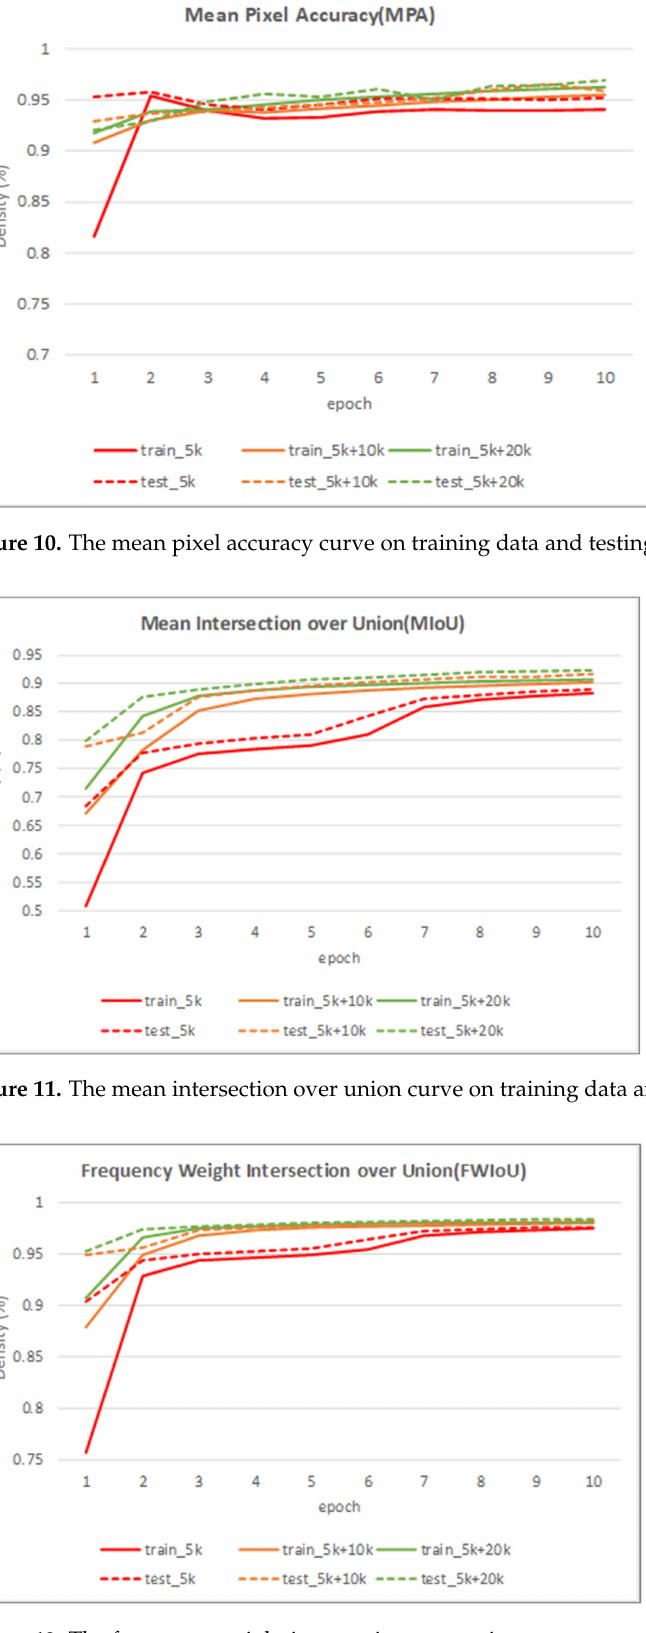
Figure 12. The frequency weight intersection over union curve on training data and testing